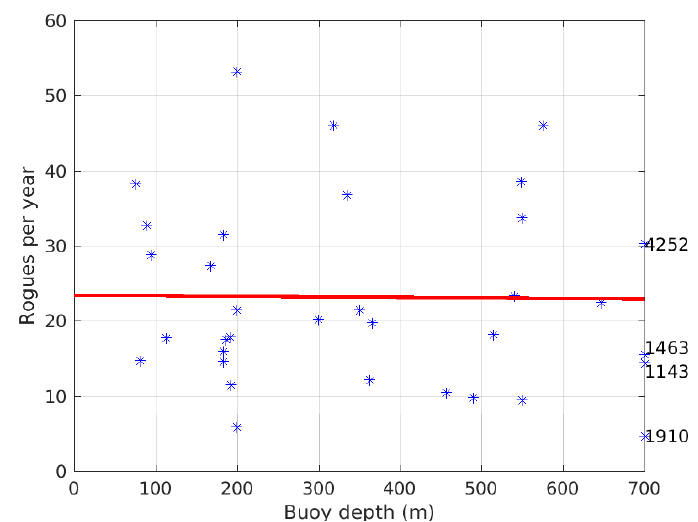
Figure 14. Rogue events per year versus water depth at each of the 34 buoy locations. Individual values plotted as blue asterisks, with best-fit shown by red line. Locations with depth greater than 700 m are plotted along the right vertical axis, with depth values listed next to each asterisk.